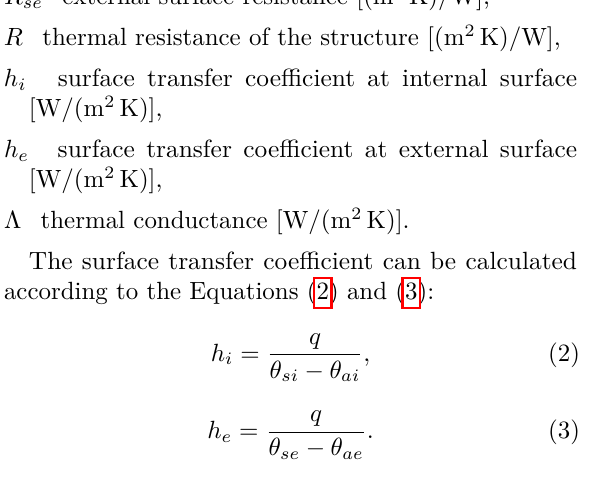
R se external surface resistance [(m 2 K)/W], R thermal resistance of the structure [(m 2